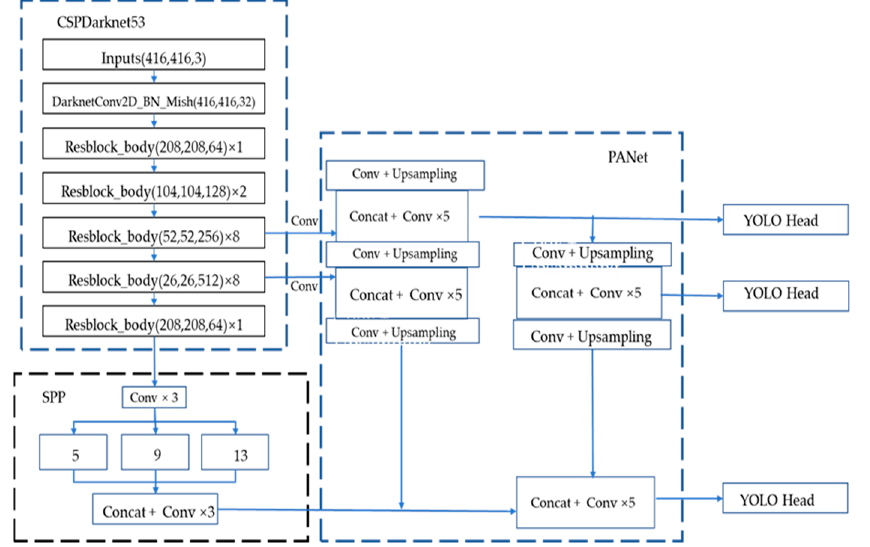
Figure 3. Structure of YOLOv4 [29].